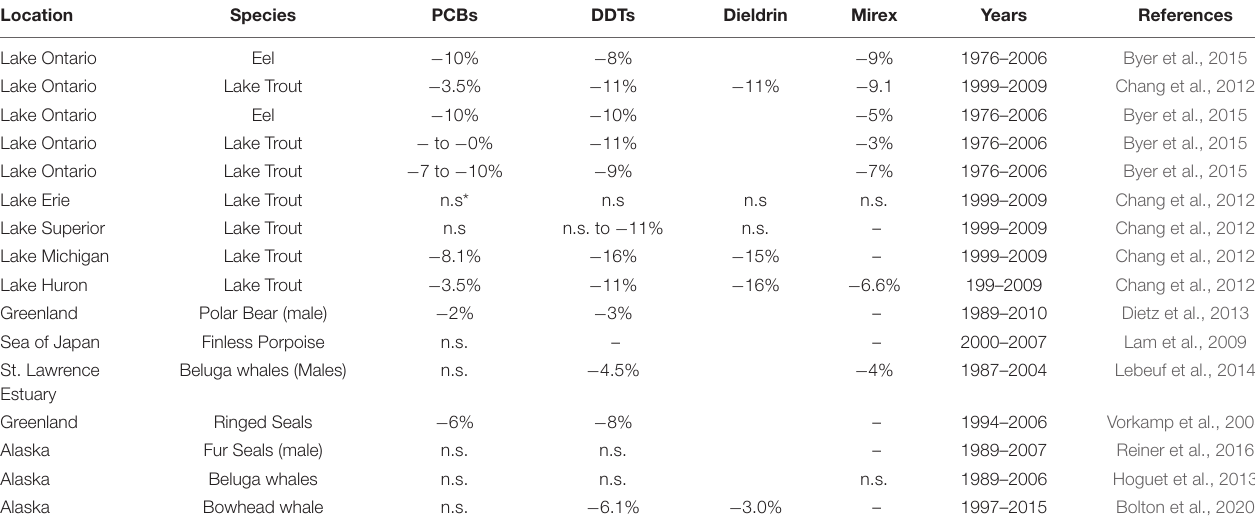
TABLE 3 | Example temporal changes in species from other